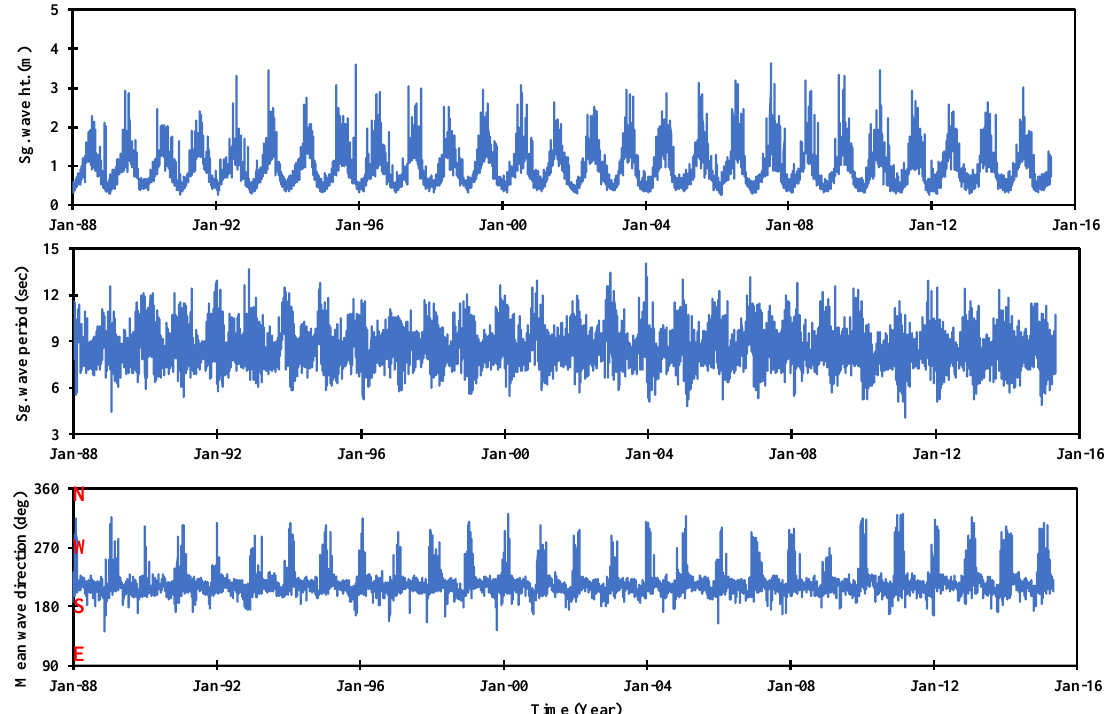
Figure 3. Variation in significant wave height, wave period, and wave direction during 1988–2014 at 92 ◦ E and 21.25 ◦ N retrieved from ECMWF ERA-Interim data.